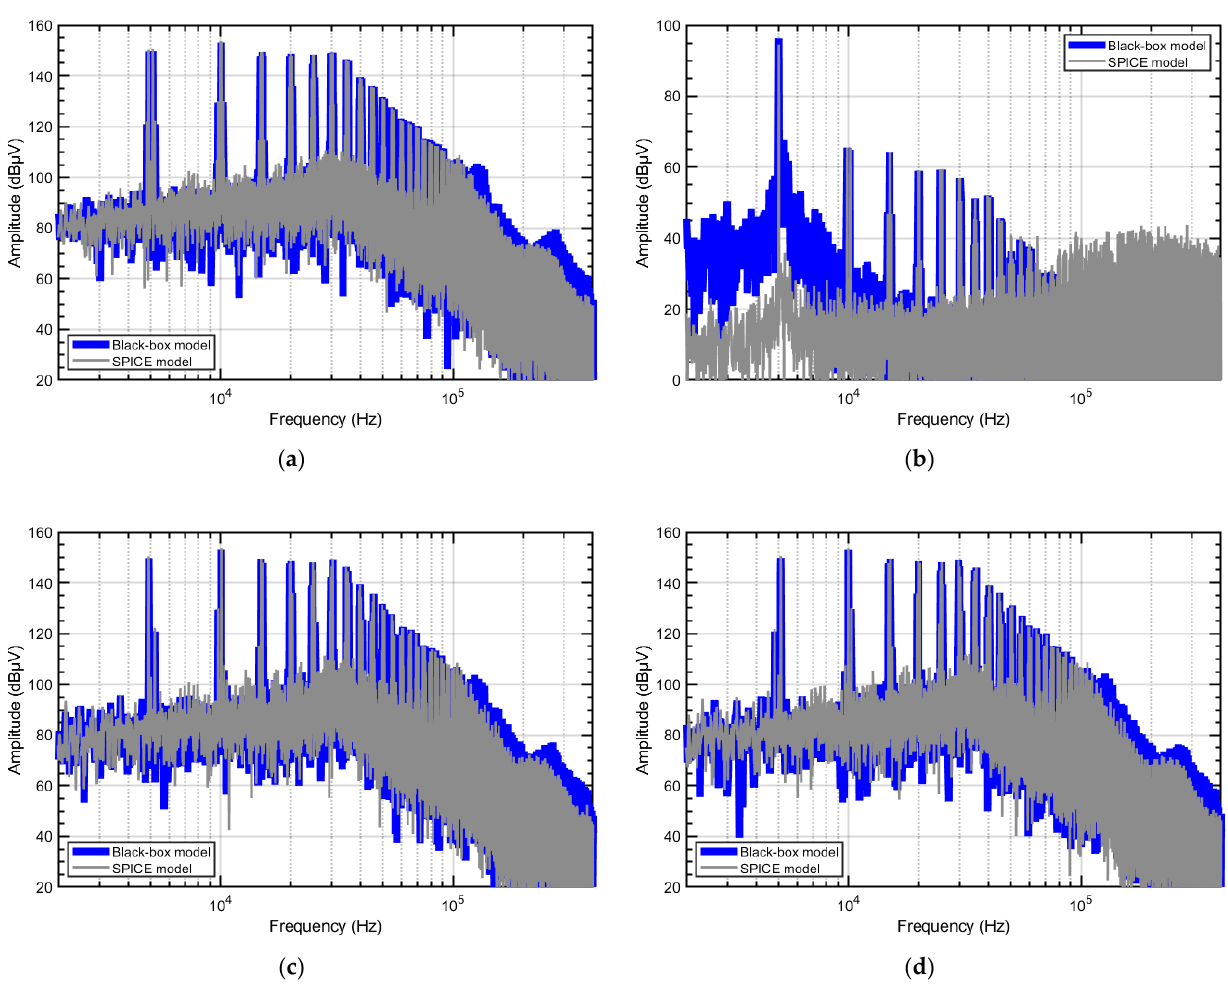
Figure 13. Conducted emissions in the absence of LCL filter obtained by SPICE model in Section 3 and predicted by the black-box model ( a ) phase voltage ( b ) zero-sequence voltage ( c ) positive sequence voltage and ( d ) negative sequence voltage.